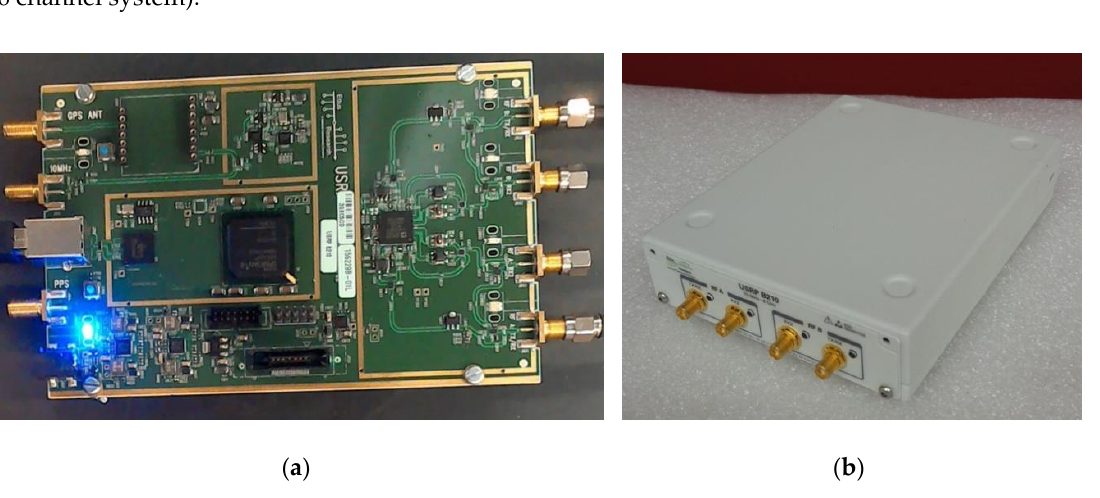
Figure 2. Photographs of the B210 USRP circuit board ( a ) without and ( b ) with a commercial cover.